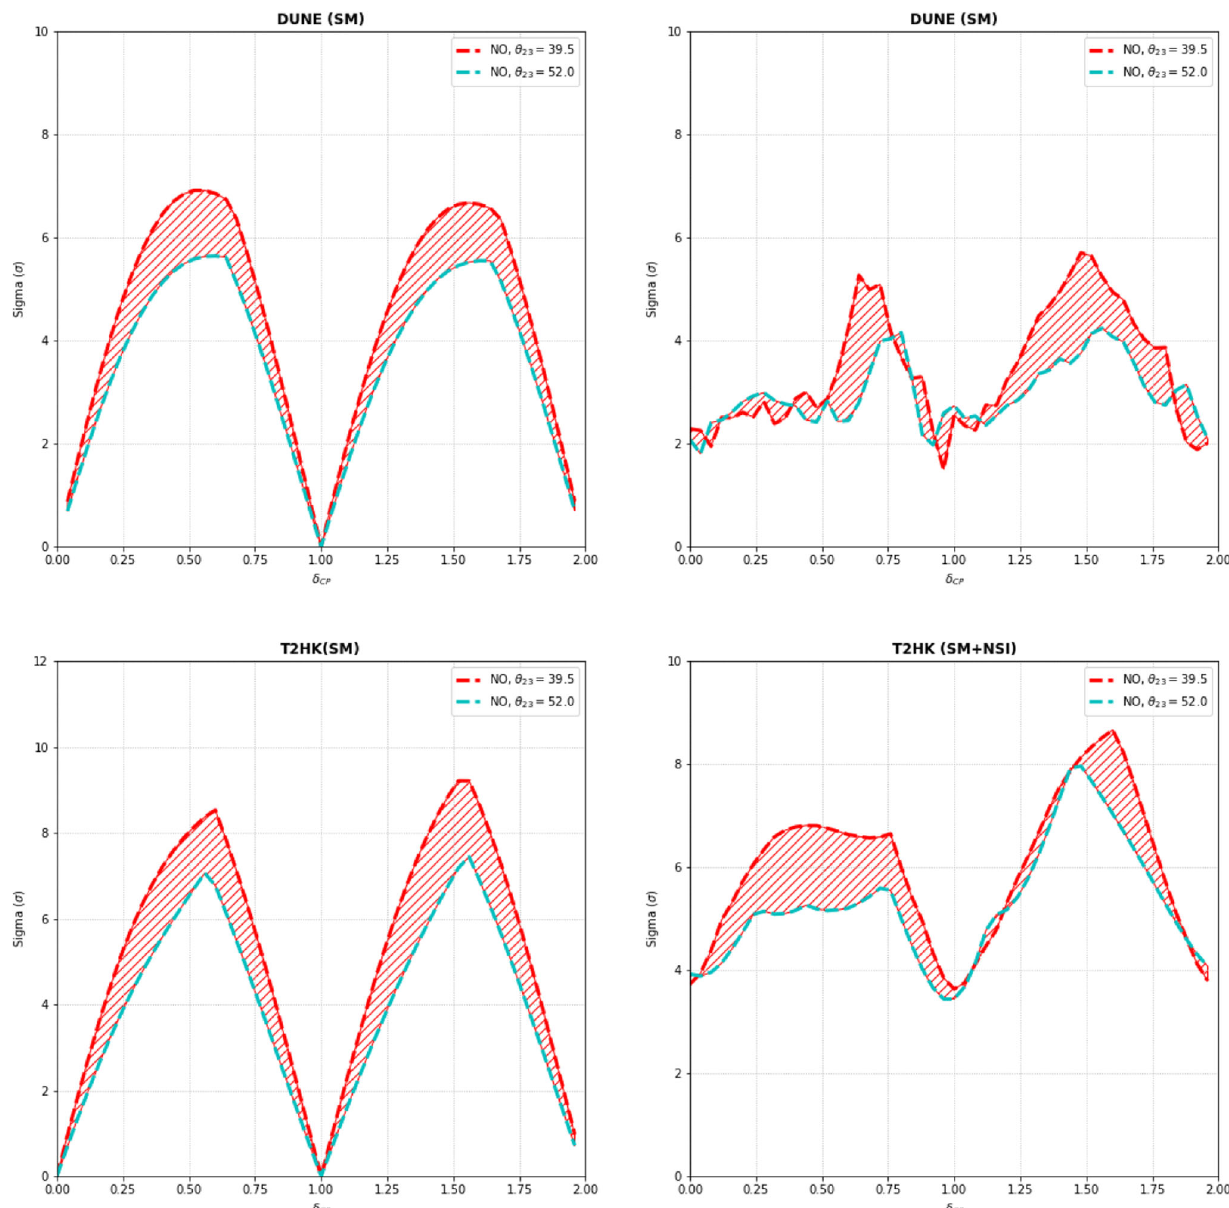
Fig. 8 CP discovery potential for DUNE (top panel) and T2HK (bottom panel) as a function of the true value of the leptonic CP phase for NO in SM scenario (left panel) and SM+NSI scenario (right panel). The bands represent the range in sensitivity obtained under the two different assumption of θ 23